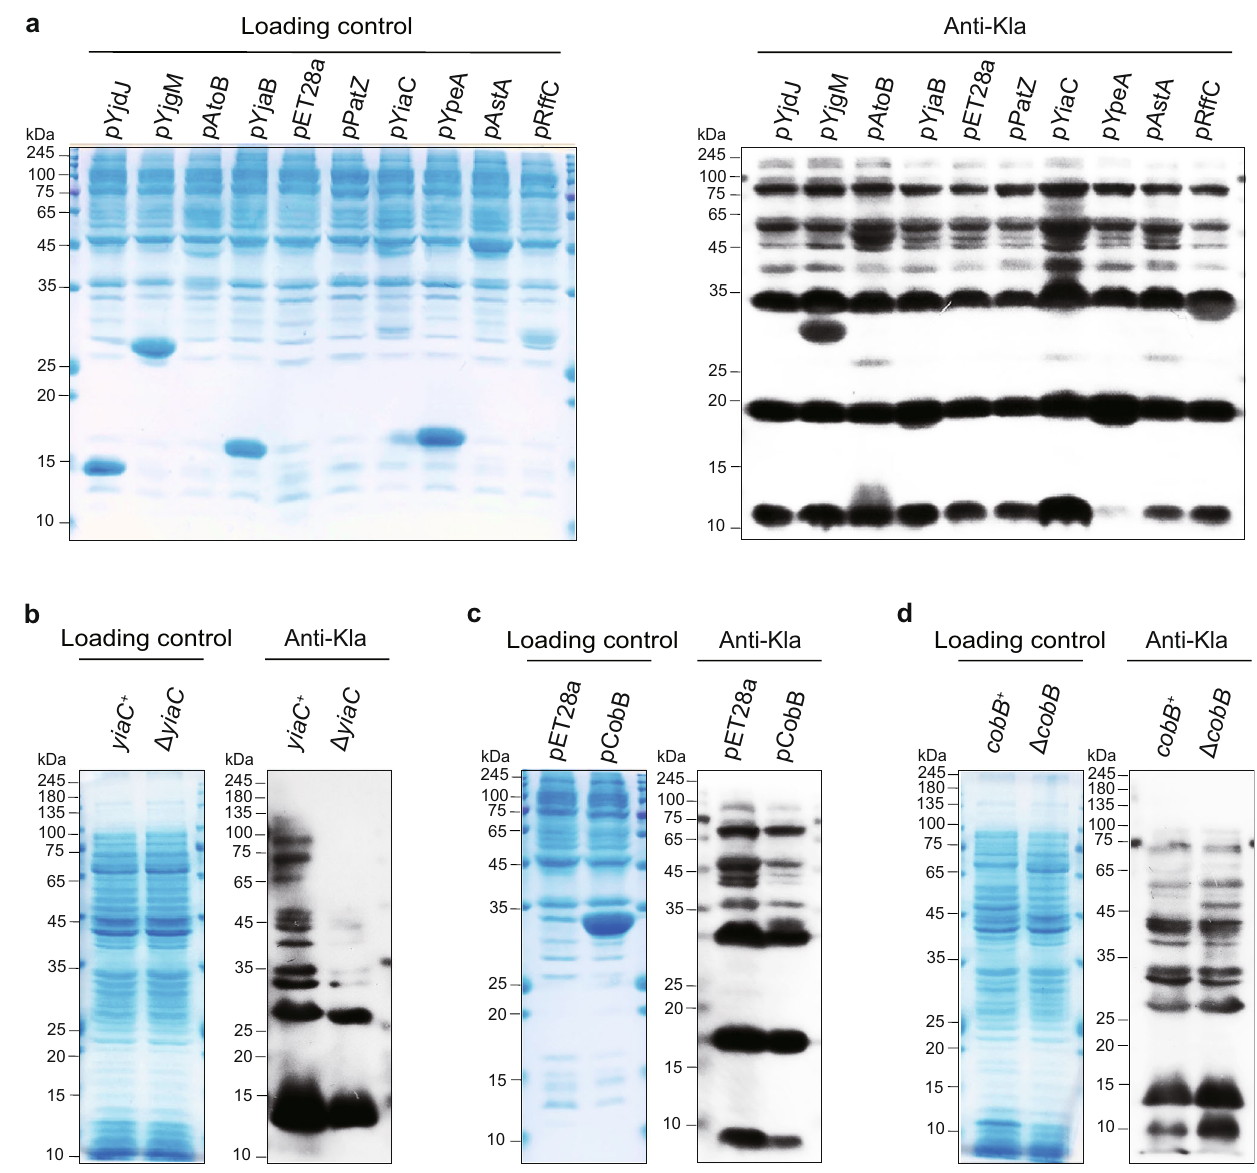
Fig. 1 | Identi fi cation ofregulatory system for Kla in E.coli . a Overexpression of YiaCincreasedKlalevelsin E.coli . E.coli BL21( λ DE3)wastransferredwiththeempty vector (pET28a) as control and with vector GNAT genes -pET28a as GNAT- overexpressing strains (pGNAT), the Kla level of whole-celllysateswasanalyzed by immunoblotting. b De fi ciency of YiaC decreased Kla in E. coli . Kla level of E. coli MG1655 Δ yiaC was analyzed by immunoblotting, with yiaC + as